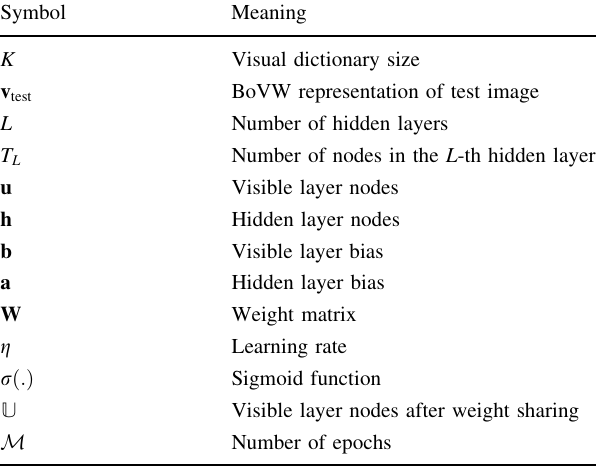
Table 1 Symbols used in this